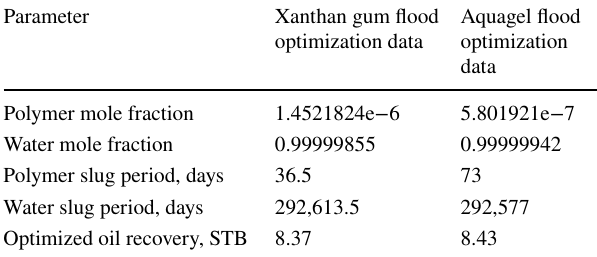
Table 4 Oil recovered with primary recovery, CO flood and polymer